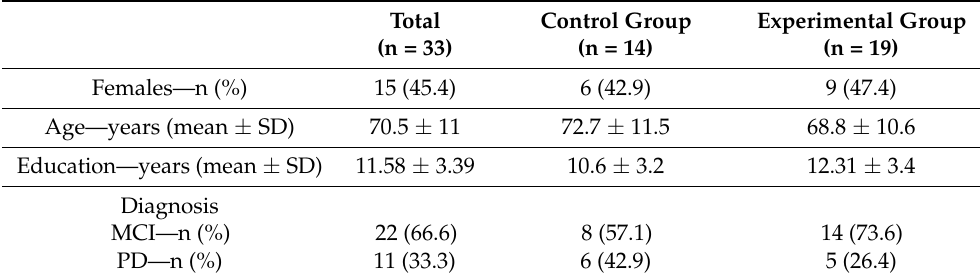
Table 1. Demographic characteristics of